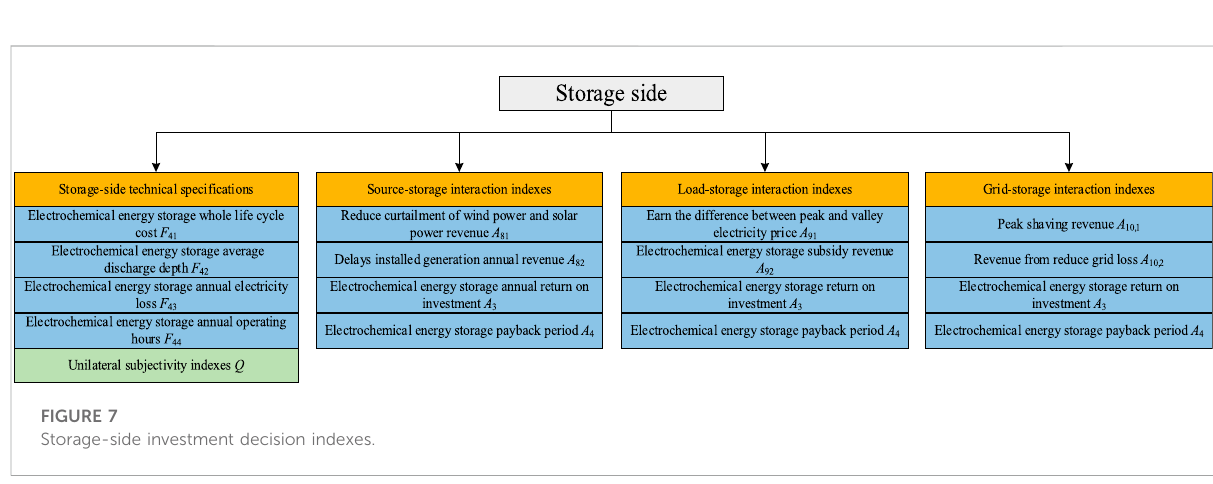
FIGURE 7 Storage-side investment decision